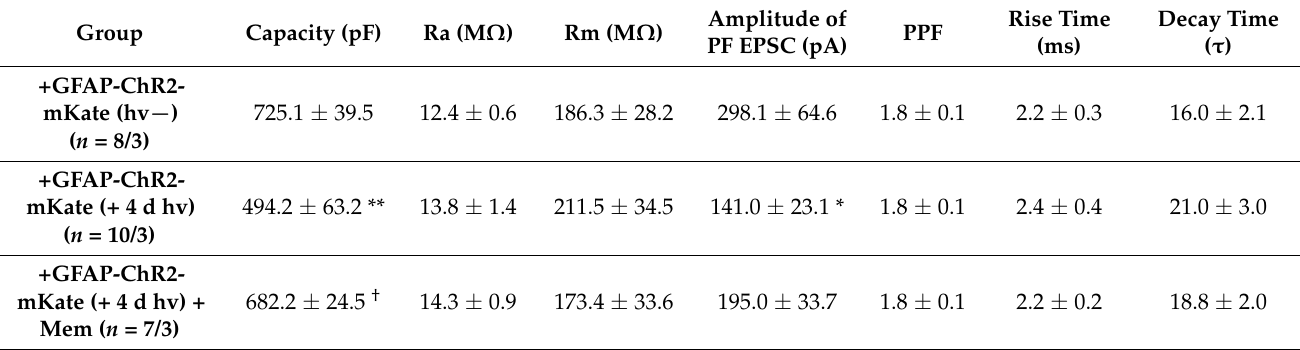
Table 1. Influence of memantine on basic passive electrophysiological and AMPA receptor-mediated EPSCs in PC in mice injected with AVV GFAP-ChR2-mKate after chronic photostimulation. Kinetics of PF EPSCs (10–90% rise time and decay time constant) and their amplitudes are shown. Paired-pulse facilitation (PPF) of PF EPSCs was analyzed using two stimuli with an interstimulus interval of 50 ms. Ratios of PPF were measured as the second EPSC amplitude normalized to the first one. One-way ANOVA followed by Tukey’s post hoc test indicates significant effects in Capacitance and Amplitude. n —number of cells/number of animals, * p < 0.05; ** p < 0.001; † p <